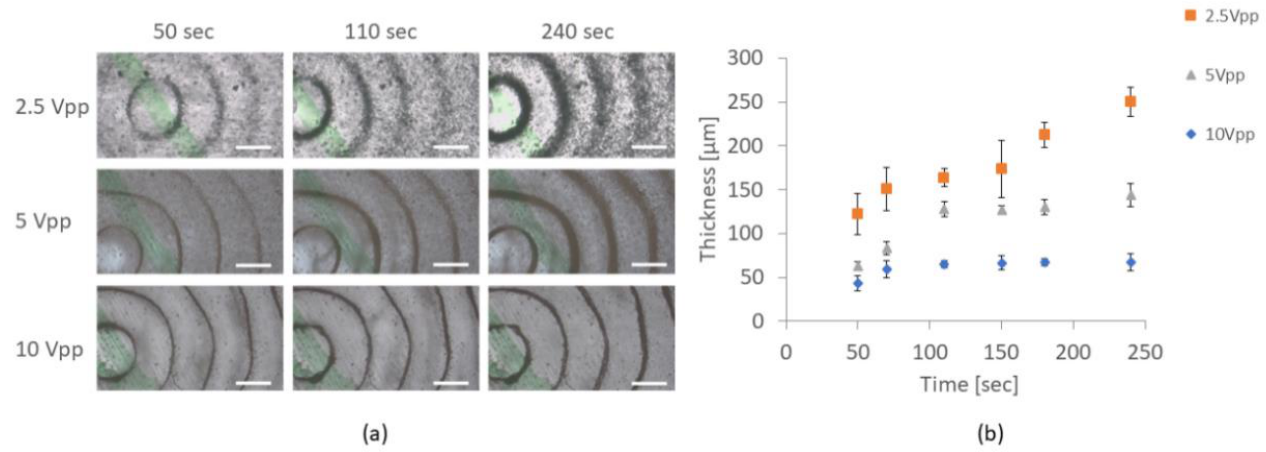
Figure 3. ( a ) Micrographs of triamcinolone acetonide particles arranged in concentric rings inside the acoustic resonator, corresponding to the location of standing acoustic wave nodes (spacing of 0.75 ± 0.1 mm). The thickness of the rings increased over time for all amplitudes as more material accumulated. Stronger acoustic waves resulted in thinner and denser rings. Scale bars = 0.7 mm. ( b ) Thickness of the second ring from the center as a function of time for various amplitudes.